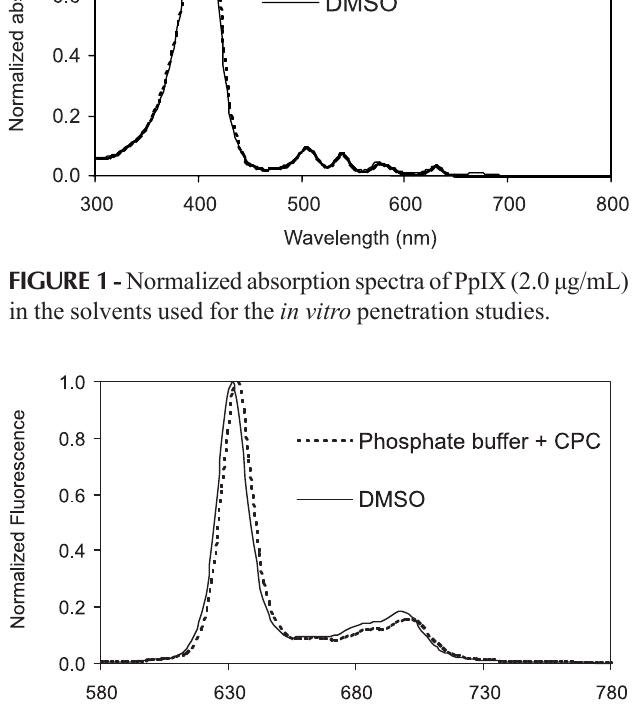
emission (nm) = max.